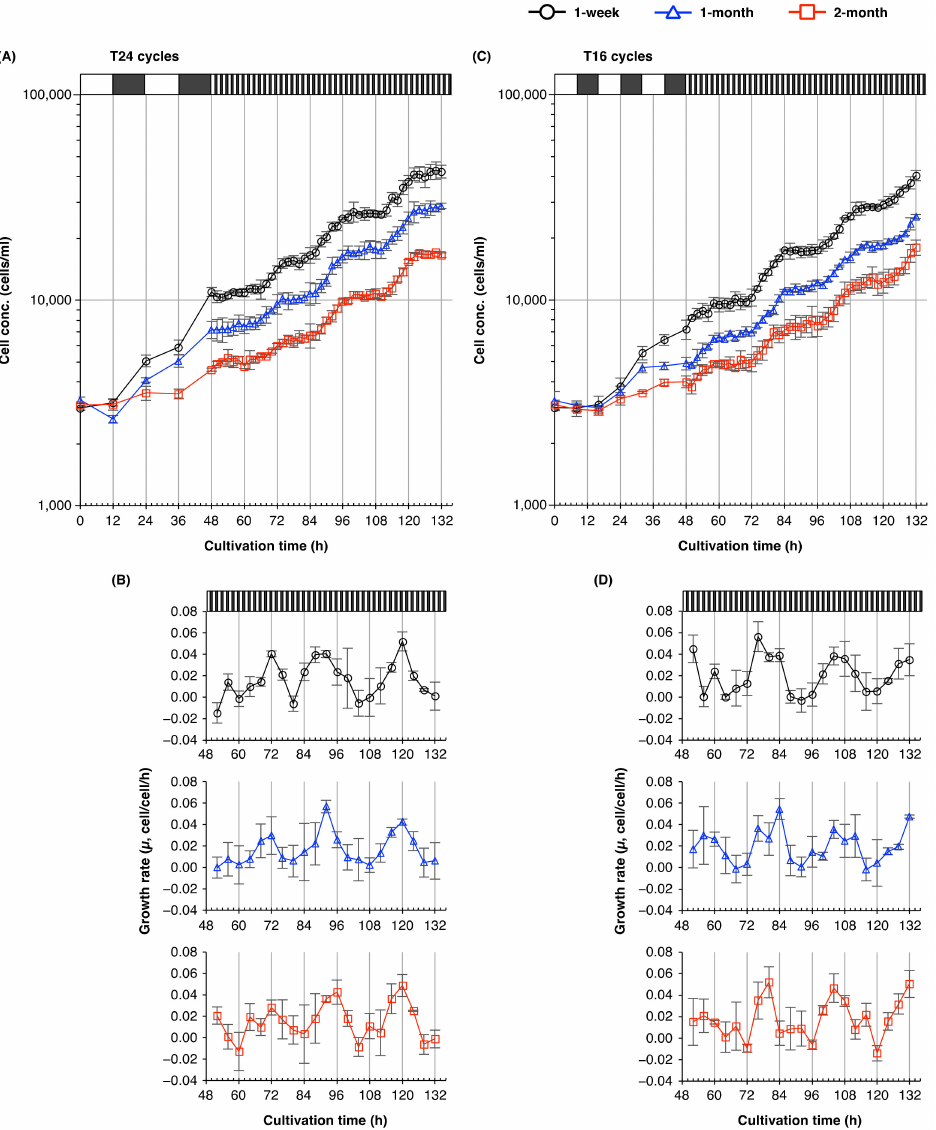
Figure 5. Rhythms of the cell division cycle of E. gracilis from young and old cultures exposed to T16 cycles. Time courses of ( A , C ) cell concentration and ( B , D ) growth rate ( µ , cell/cell/h) of E. gracilis cells from 1-week-old, 1-month-old, and 2-month-old cultures under free-running conditions following entrainment to T24 and T16 cycles. E. gracilis cells were cultured under T24 cycles for 1 week, 1 month, and 2 months, and subsequently inoculated into fresh medium. Algal cells were cultured under T24 or T16 cycles for 48 h and then transferred to free-running conditions (1 h/1 h light/dark cycles) for 3.5 days. Data are means ± SD ( n = 3). Growth rates under free-running conditions were calculated over 4-h